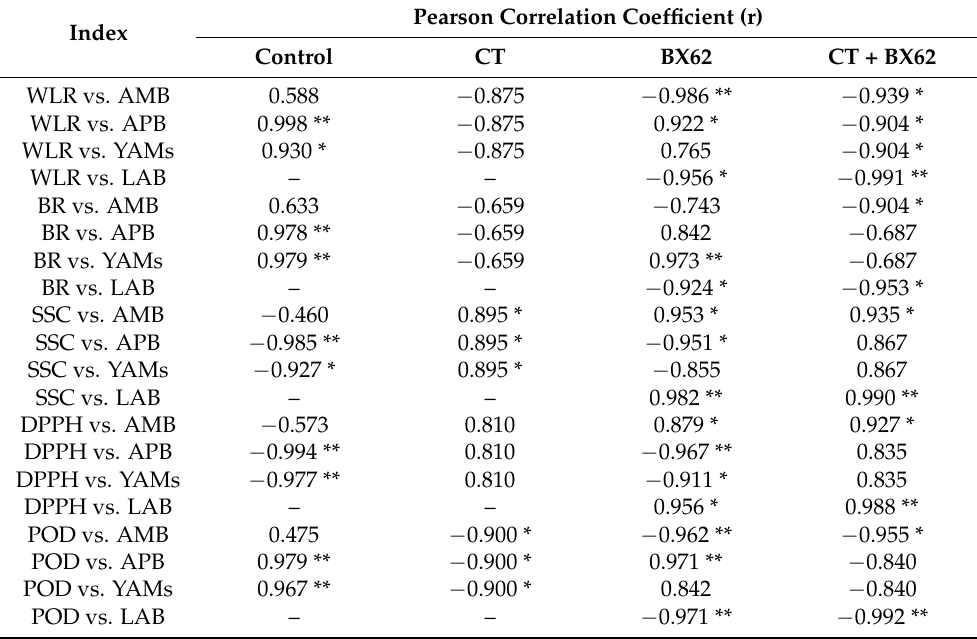
Table 2. Correlation between some selected quality parameters of fresh-cut apples in different groups during cold